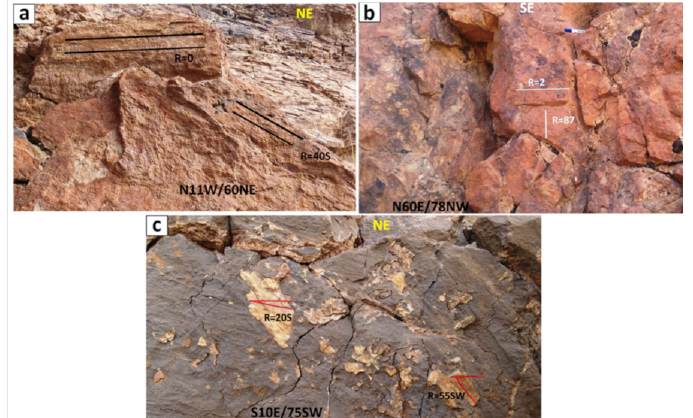
Figure 10. Field photo of the study area’s faults in two different stress regimes: ( a ) dextral and reverse with a dextral component in site 18; ( b ) strike-slip with a normal component in volcanic rocks unit in site 16; ( c ) dextral with reverse component and normal with a dextral component in site